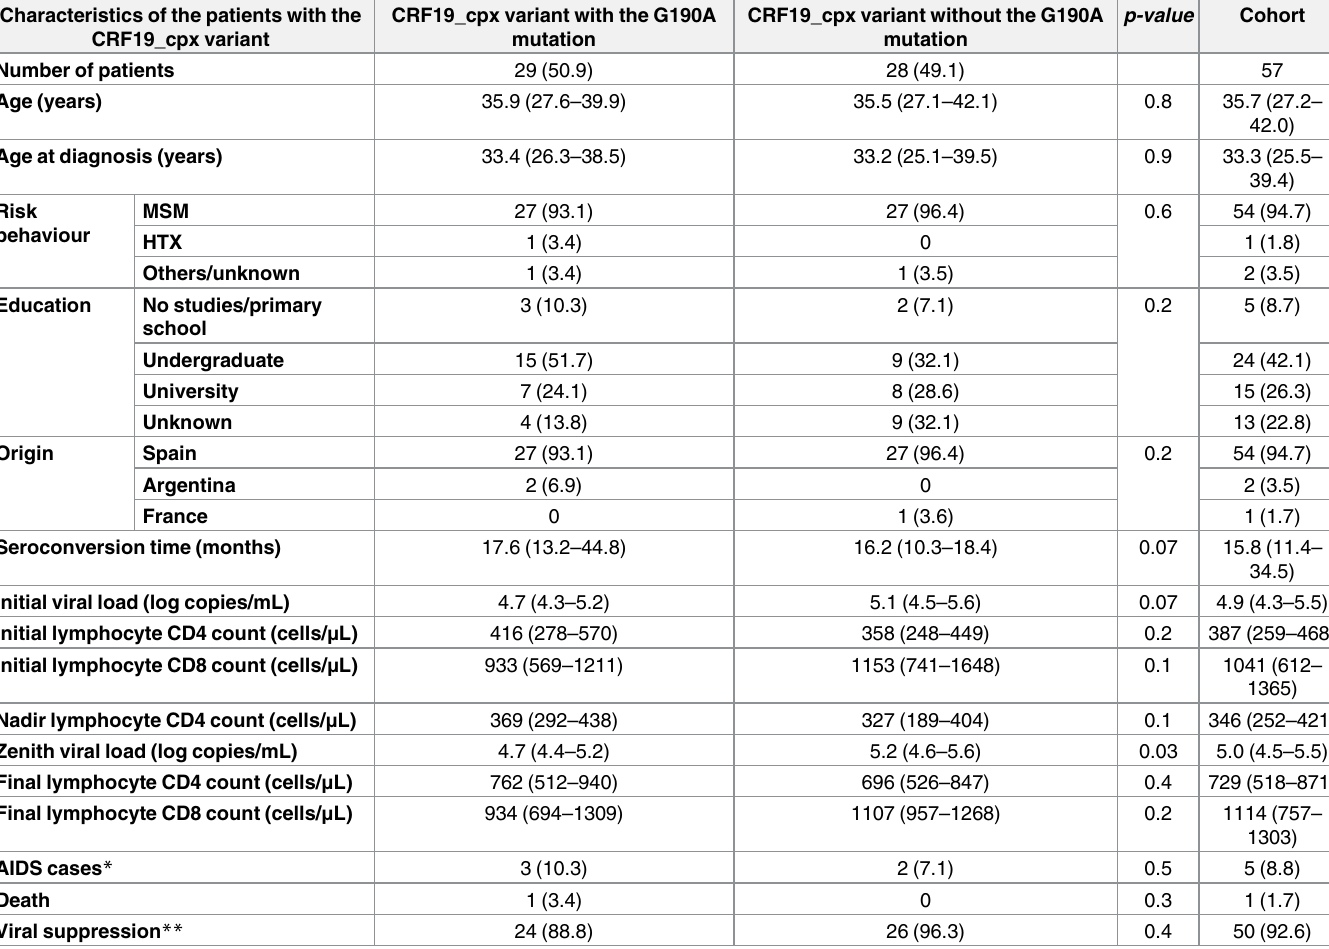
Table 2. Characteristics of the 57 patients with the CRF19_cpx variant and comparison of the groups with and without the G190A mutation. Characteristics of the patients with the CRF19_cpx